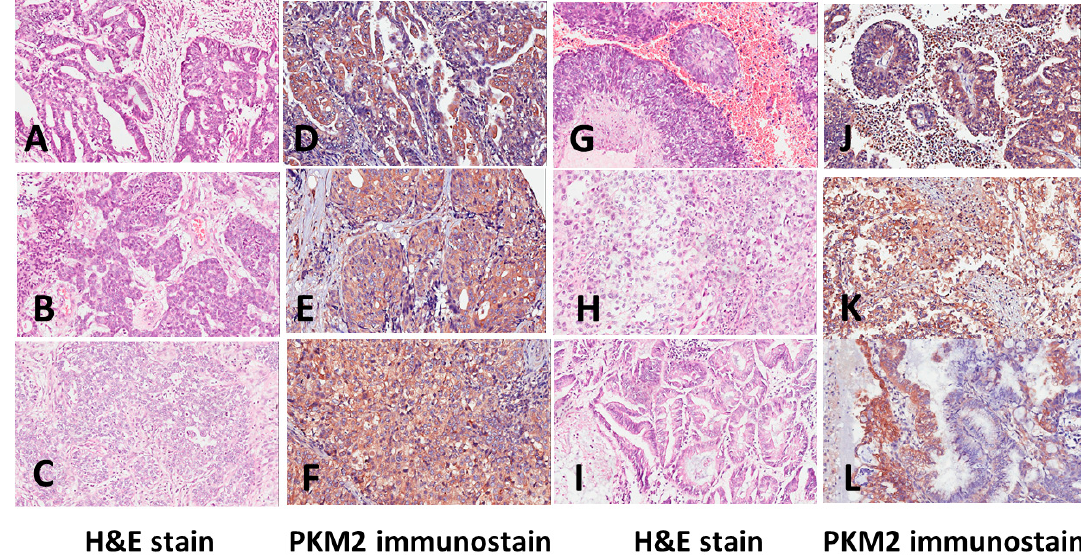
Figure 2. Examples of hematoxylin and eosin (H&E) staining of ( A ) grade 1 endometrioid adenocarcinoma, ( B ) grade 2 endometrioid adenocarcinoma, ( C ) grade 3 endometrioid adenocarcinoma, ( G ) serous carcinoma, ( H ) clear cell carcinoma, and ( I ) mucinous carcinoma and pyruvate kinase M2 (PKM2) immunostaining of ( D ) grade 1 endometrioid adenocarcinoma, ( E ) grade 2 endometrioid adenocarcinoma, ( F ) grade 3 endometrioid adenocarcinoma, ( J ) serous carcinoma, ( K ) clear cell carcinoma, and ( L ) mucinous carcinoma.